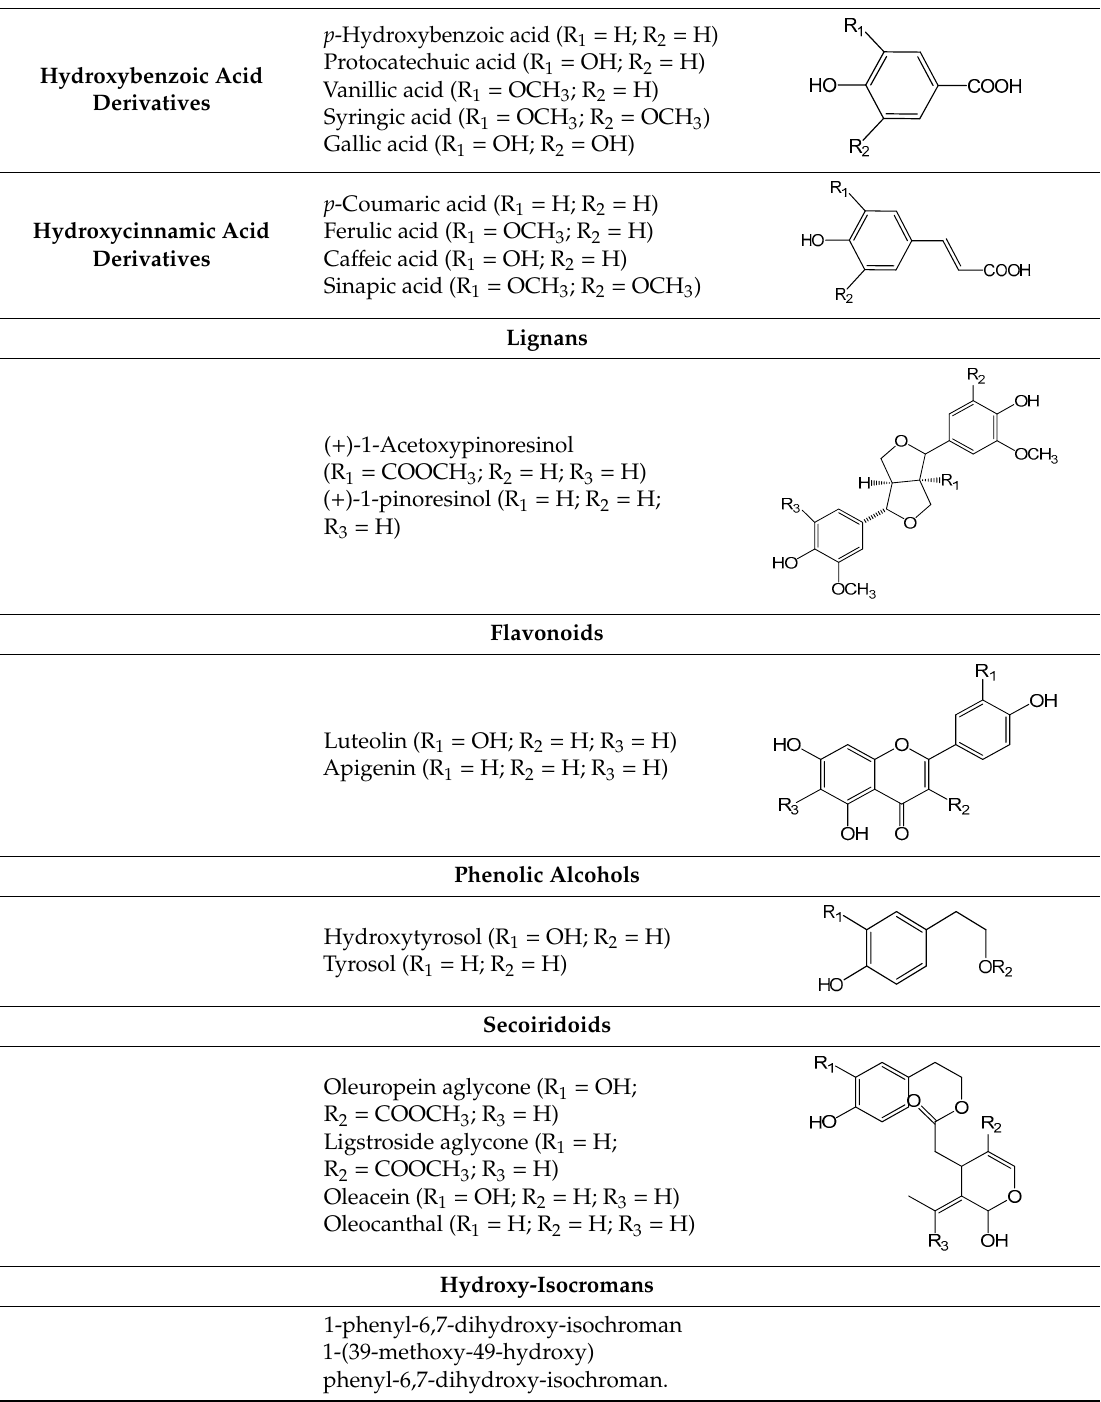
Table 1. Classification of phenolic compounds in extra-virgin olive oil (EVOO).